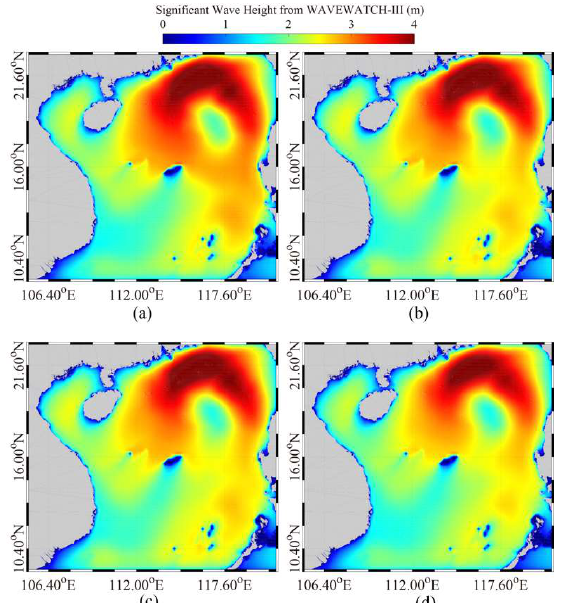
Figure 5. The simulated SWH maps using the three packages of nonlinear term for quadruplets wave–wave interactions in Typhoon Khanun at 12:00 a.m. UTC on 15 October 2017. ( a ) simulated results using the DIA package; ( b ) simulated results using the WRT package; ( c ) simulated results using the GMD1 package; ( d ) simulated results using the GMD2 package.